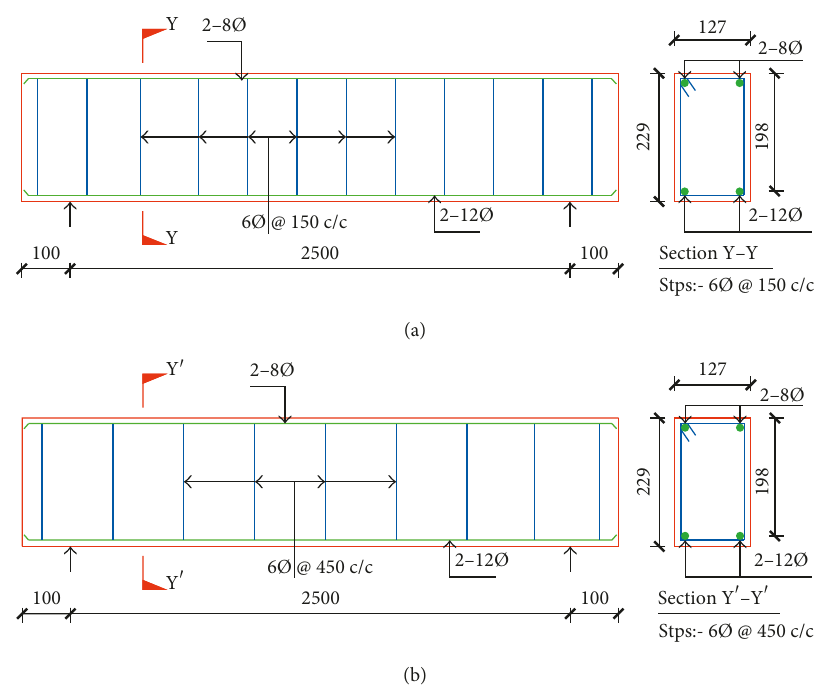
Figure 1: Beam section and reinforcement details: (a) shear-designed beams (DBs); (b) shear-deficient beams (SDBs).